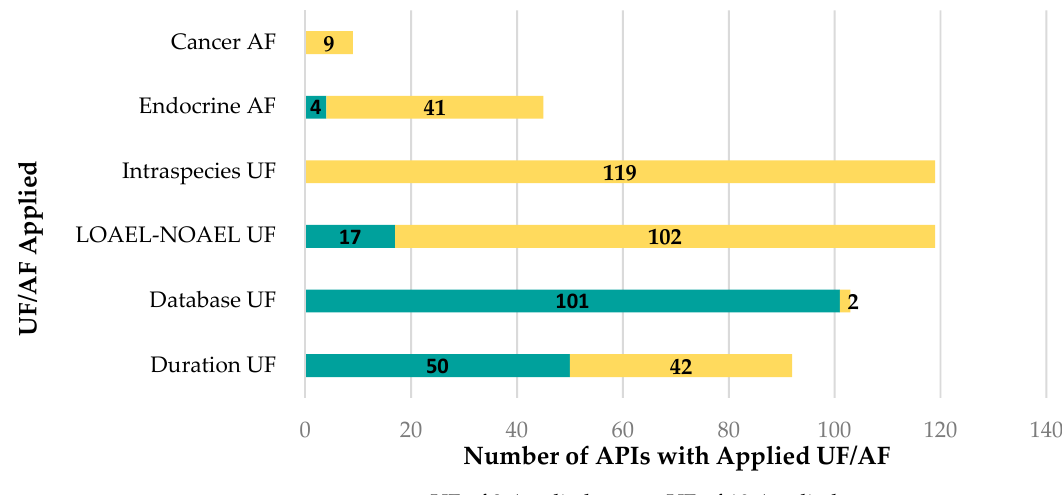
Figure 3. Frequency of Uncertainty (UF) and Adjustment (AF) Factors (described in Section 2.4) Application During Derivation of API sRfD including application of UF/AF of 3 or 10 applied for the Cancer AF (AF C ), Endocrine AF (AF E ), Intraspecies UF (UF Human ), LOAEL-NOAEL UF (UF L-N ), Database UF (UF DB ), and the Duration UF (UF S-C ).